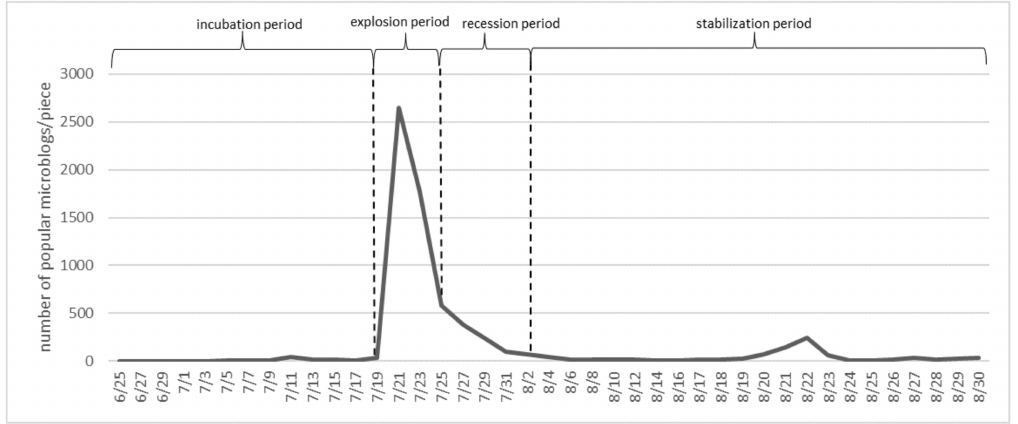
Figure 4. Public opinion event popular microblog trend.